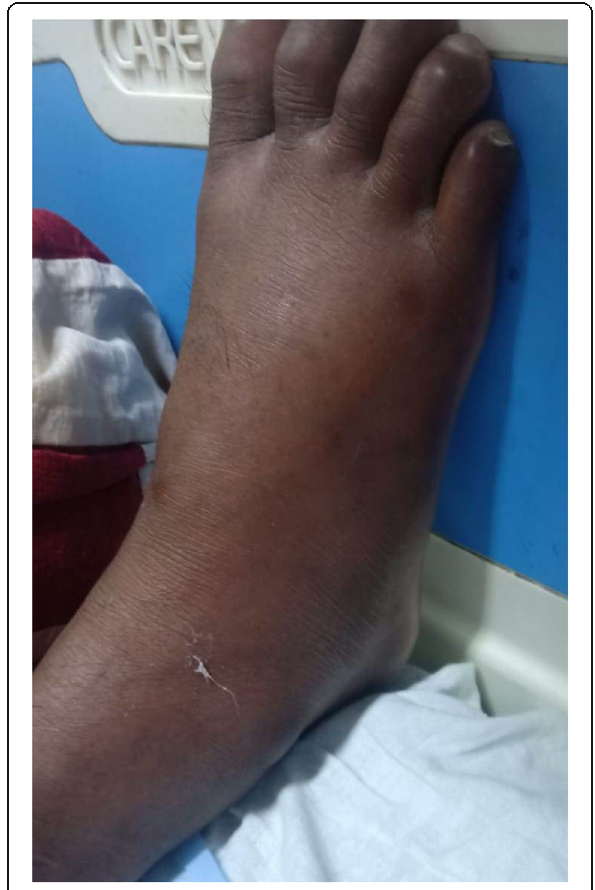
Fig. 1 Photograph of right foot showing cellulitis (note